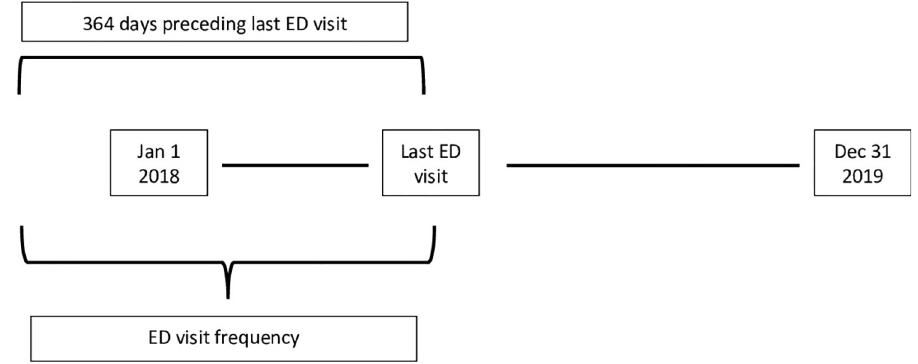
Fig 1. Method to determine emergency department (ED) visit frequency for